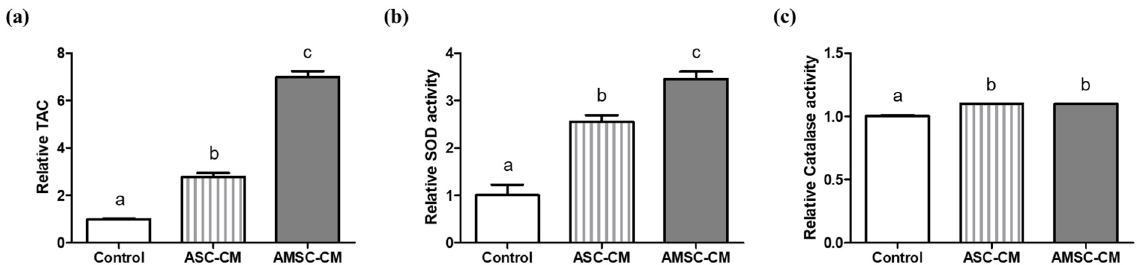
Figure 4. Comparison of antioxidant biomarkers level in human adipose-derived mesenchymal stem cell conditioned medium (ASC-CM) and amniotic membrane-derived mesenchymal stem cell conditioned medium (AMSC-CM). ( a ) Total antioxidant capacity (TAC), ( b ) superoxide dismutase (SOD) activity, and ( c ) catalase activity. Data are normalized to average value of control and presented as the mean ± SEM. Superscript letters in each column indicate significant differences ( p < 0.05).